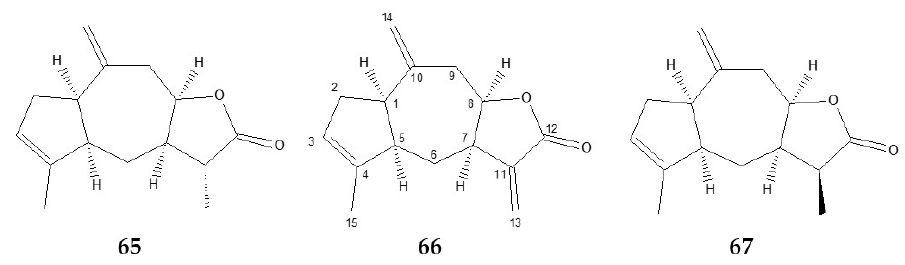
Figure 2. Structures of xantholide B 65 , ziniolide 66 , and 11 β -dihydroziniolide 67 . Ziniolide was isolated for the first time from Zinnia peruviana (L.) L.